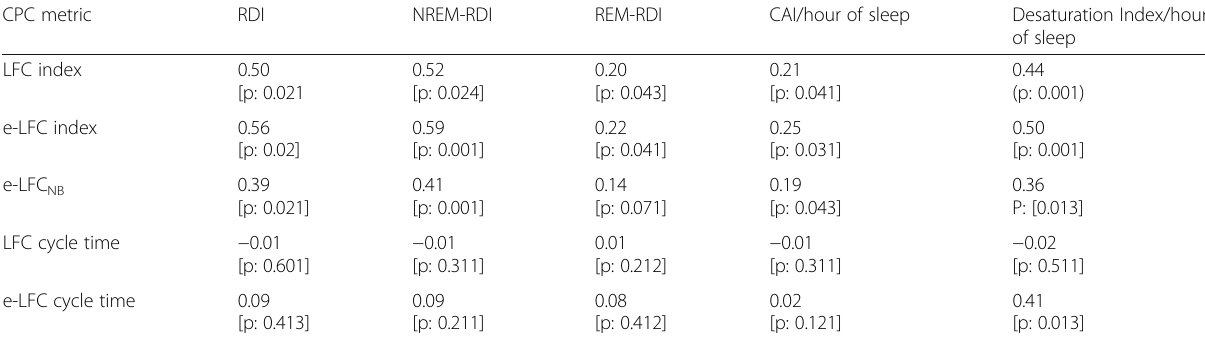
Table 4 Correlation (r) of ECG-spectrogram and PSG respiratory indices CPC metric RDI NREM-RDI REM-RDI CAI/hour of sleep